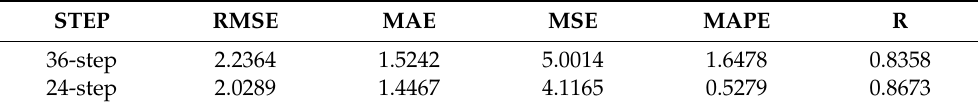
Table 6. Prediction performance of the model with multiple input variables. Table 8 . Prediction performance of the model with multiple input variables.